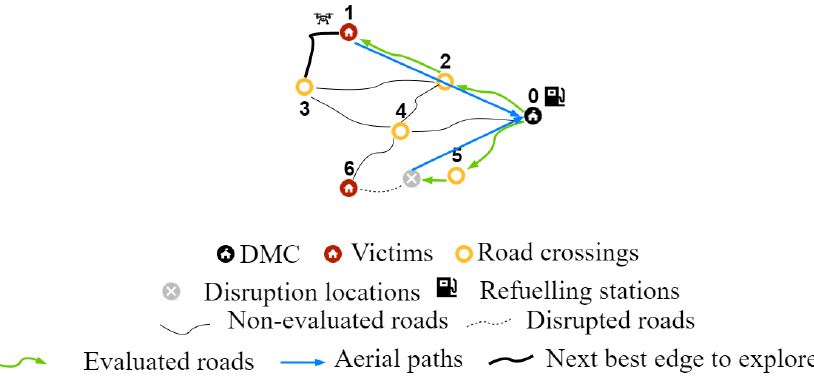
Figure 5. Example of the flying range limitation with only the DMC working as a refueling station.